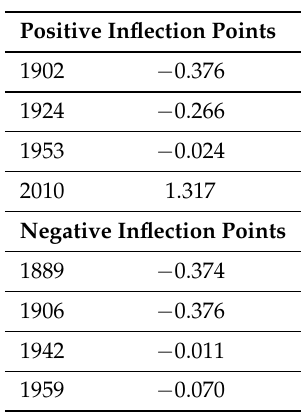
Table 1. Positive and negative inflection points of the Land Temperature anomalies.